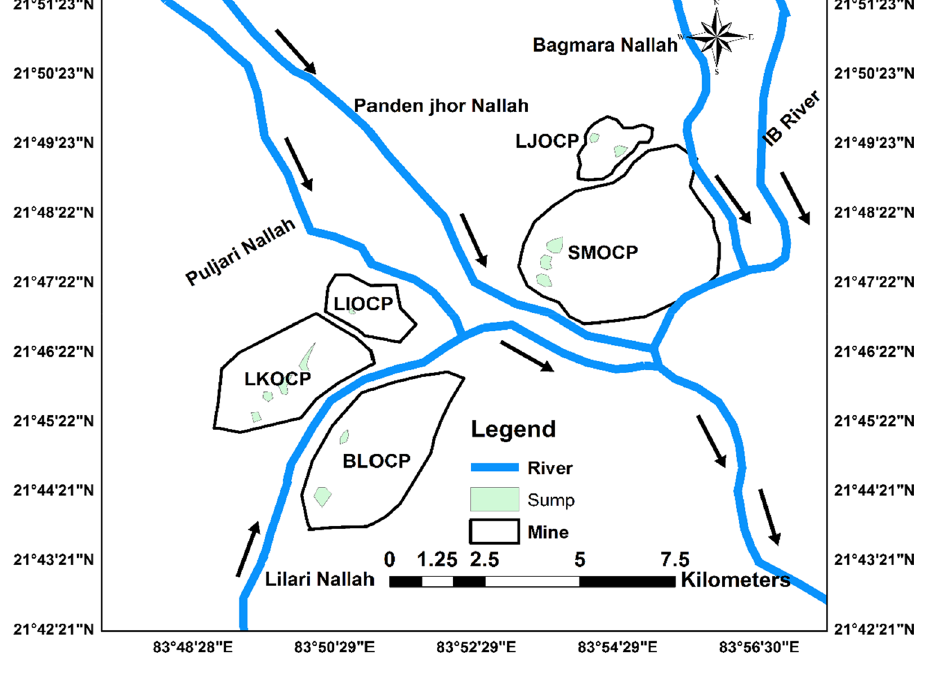
Fig. 3 Drainage pattern in Basundhara